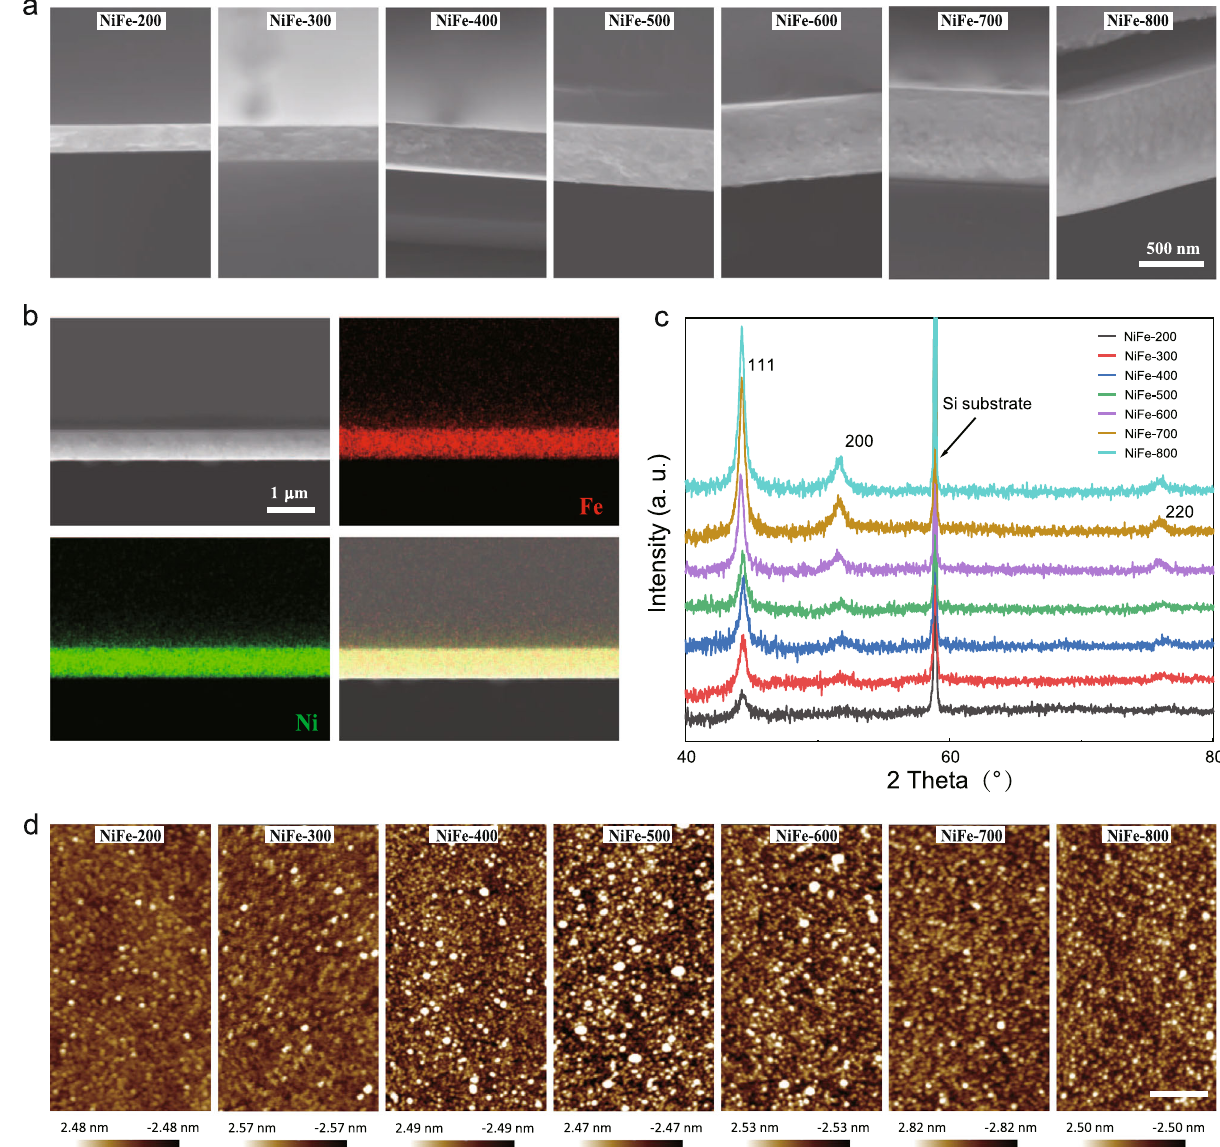
Fig.1|CharacterizationsofNiFethin fi lms.a TheSEMimagesoftheCrosssection of NiFe thin fi lms on Si substrates. The scale bar of those images is 500nm. b The EDXmappingphotosofNiFe-600(themappingphotosofother fi lmscanbefound